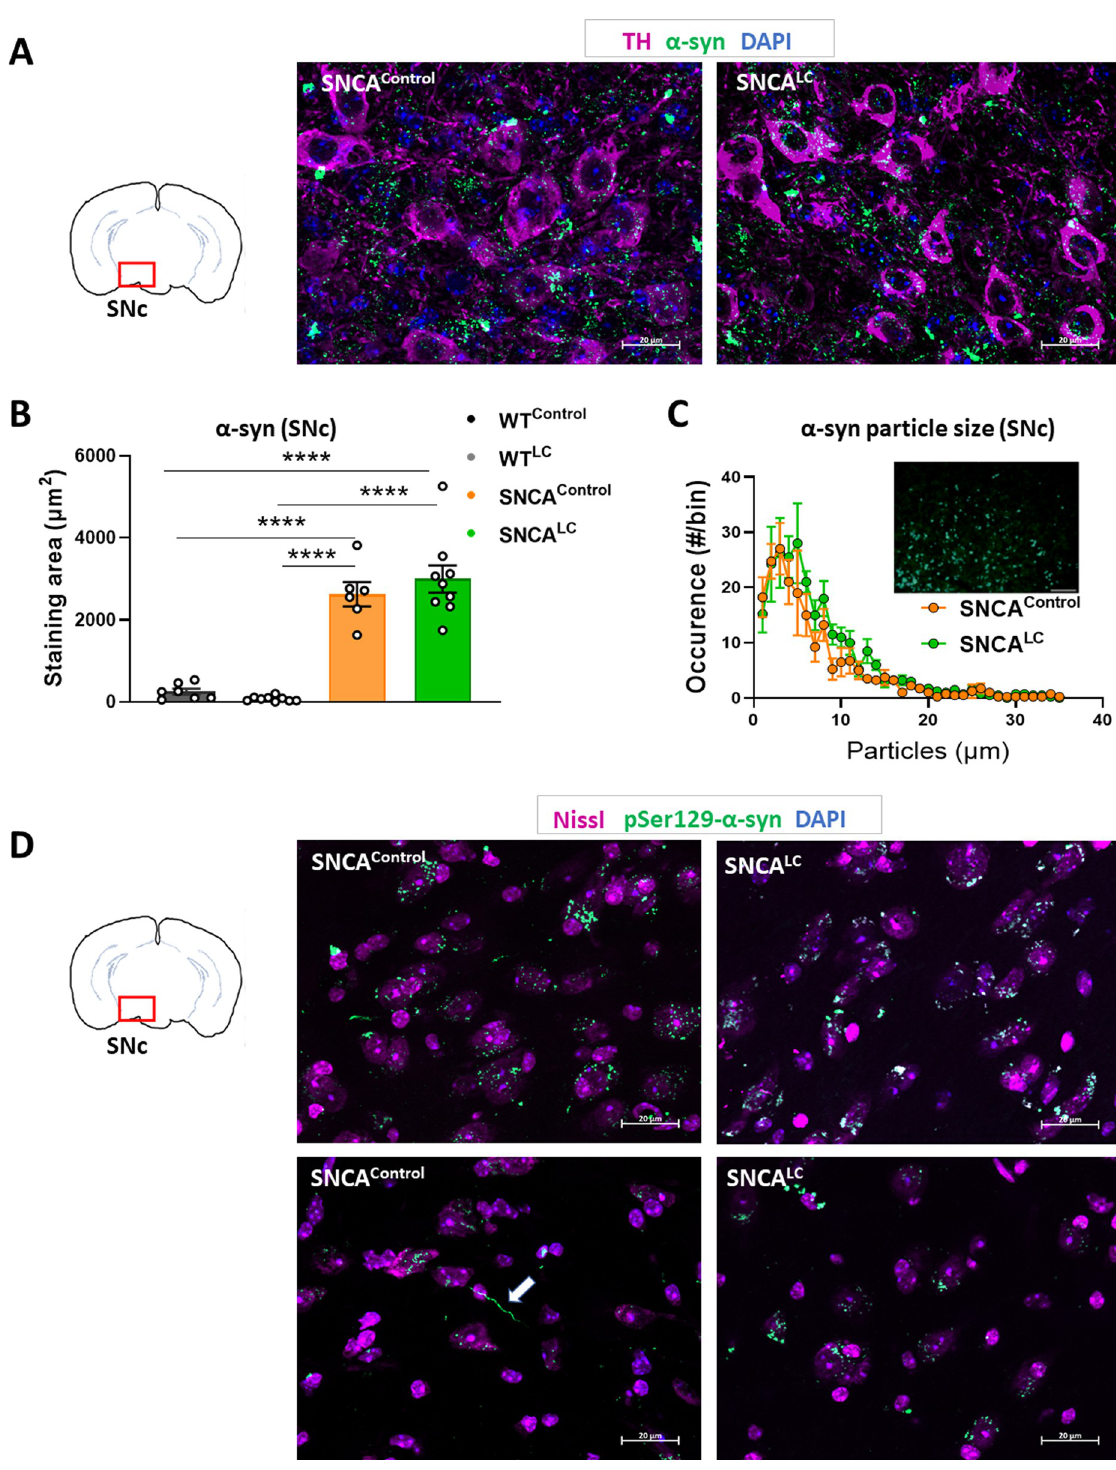
Fig 4. LC-NE activation does not mitigate α -synuclein aggregation. A- Immunohistochemistry against α -syn and TH in SNc of SNCA Control and SNCA LC mice, TH (purple), α -syn (green), DAPI (blue), scale bar 20 μ m. B- Quantification of the total area of α -syn positive staining in the SNc (n = 6–9). C- Analysis of α -syn particle size distribution in SNCA Control and SNCA LC mice (n = 4–6), right upper panel: representative image used in the analysis, obtained by BX-Z Analyzer software, scale 50 μ m. D- Immunohistochemistry against pSer129- α Syn from all groups, pSer129- α Syn (green), Nissl (magenta), DAPI (blue), scale bar 20 μ m. Arrow denotes Lewy neurites. ���� p < 0.00001, all values denote means ± SEM. https://doi.org/10.1371/journal.pone.0263074.g004 PLOS ONE | https://doi.org/10.1371/journal.pone.0263074 March 22,